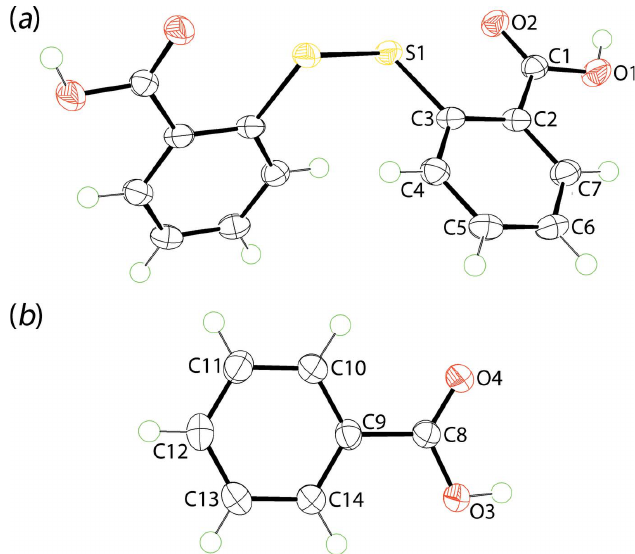
Figure 1 The molecular structures of ( a ) 2,2 0 -dithiodibenzoic acid and ( b ) benzoic acid in (I), showing the atom-labelling scheme and displacement ellipsoids at the 70% probability level. The molecule in ( a ) is disposed about a twofold axis of symmetry with unlabelled atoms related by the (cid:3) z . symmetry operation: 1 (cid:3) x , y , 1 2